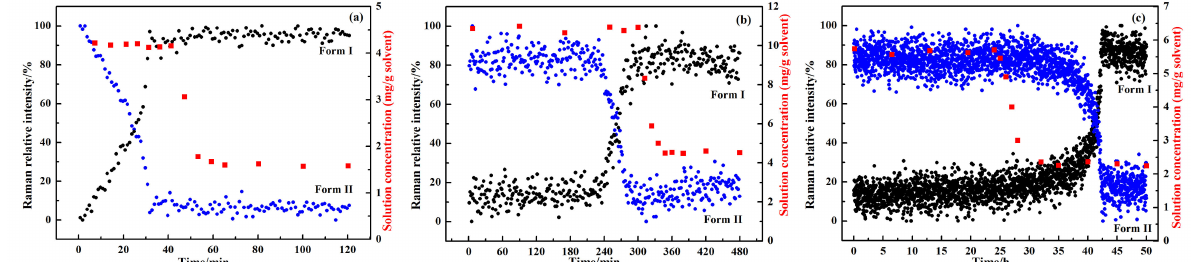
Figure 10. Changes of solution concentration during the solution-mediated polymorphic trans- formation of L-carnosine in different solvent mixtures: ( a ) water + acetone; ( b ) water + ethanol; ( c ) water + DMF.